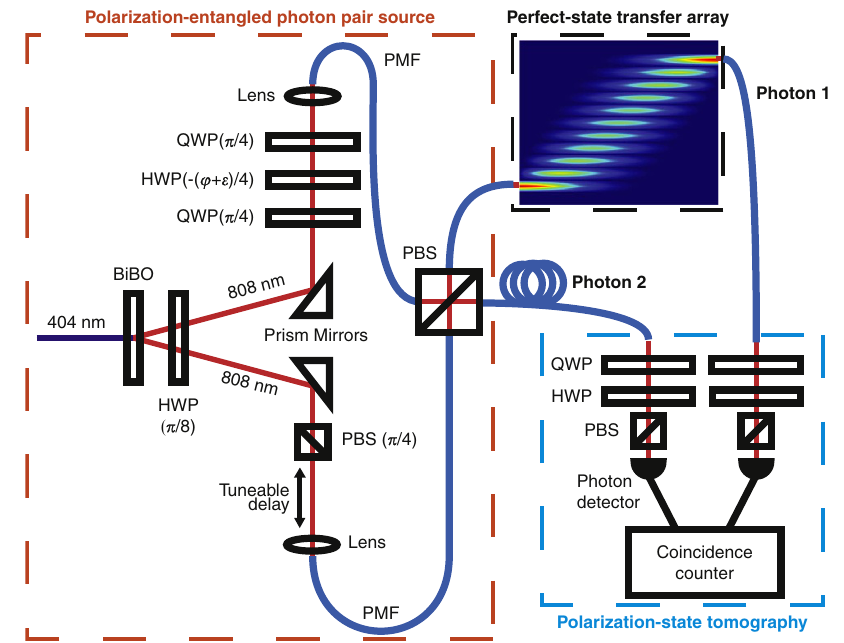
Figure 4 | Experimental set-up. Polarization entangled photons are generated in free space before coupling into PMF. Photon 1 is injected into the perfect state transfer array, while photon 2 travels through PMF. Full two-qubit polarization tomography is performed on the output. See Methods for experimental set-up details. Purity = 0.91 ± 0.03 Relative delay = 0 μ m Fidelity = 0.964 ± 0.010